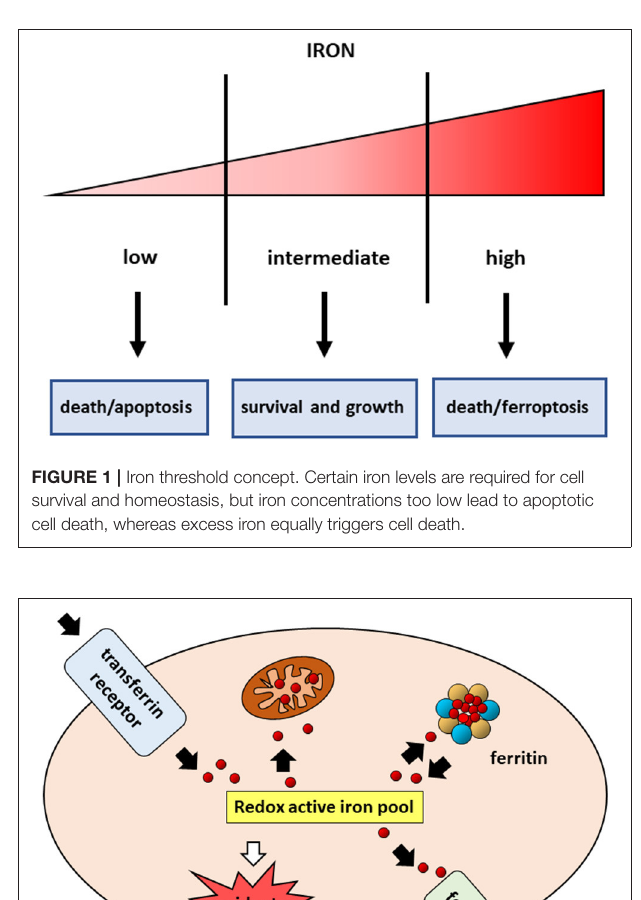
that allows the transformed cell to fully express its potential